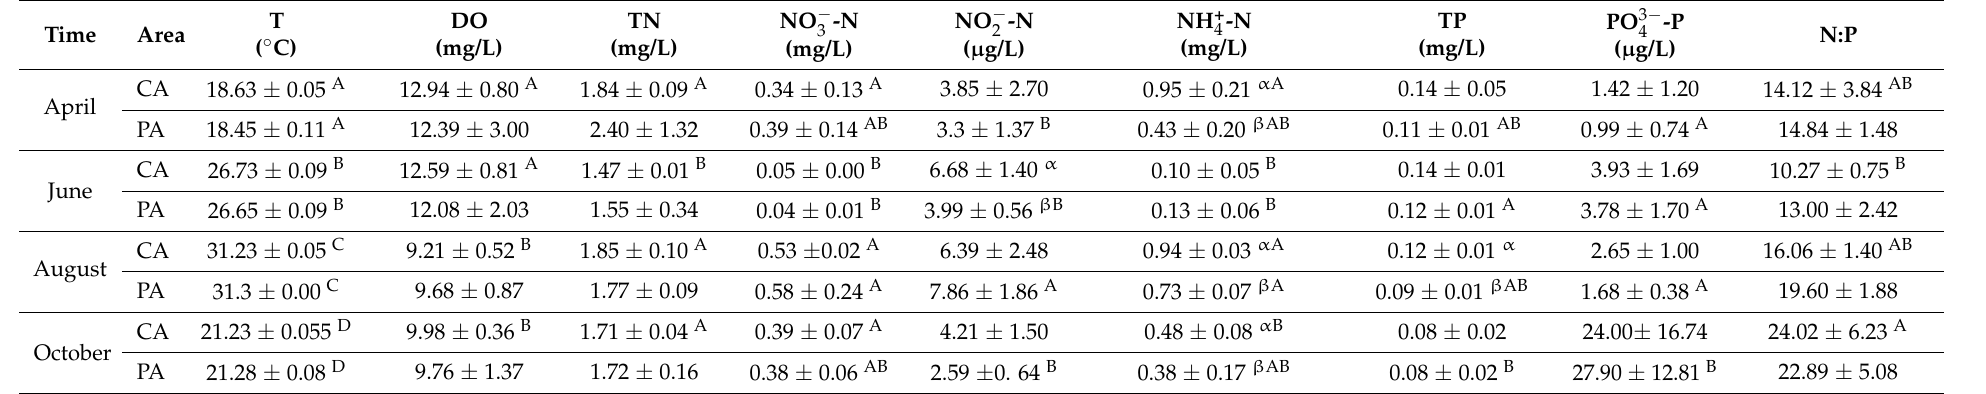
Table 2. Physicochemical characteristics of